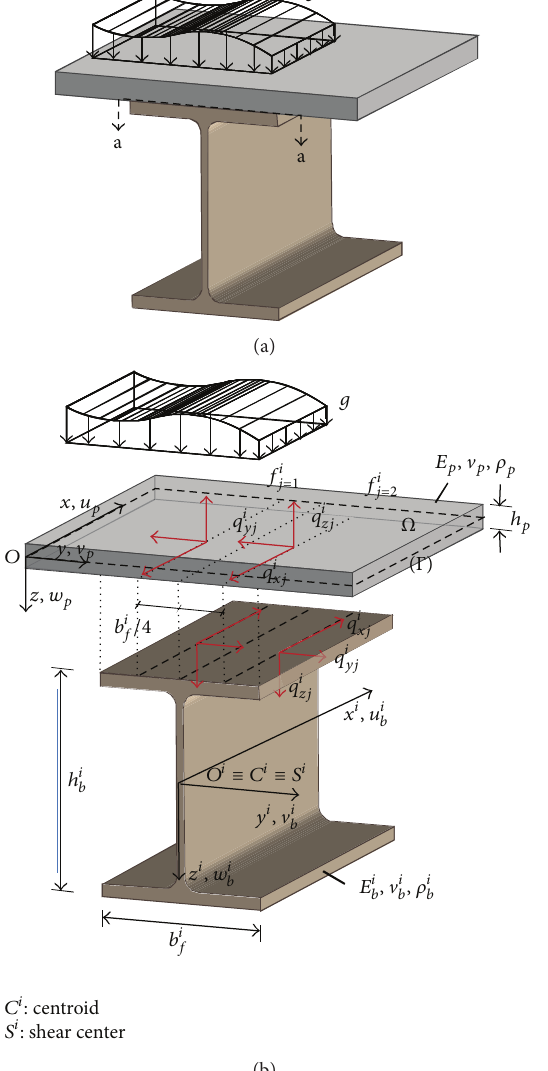
Figure 2: Thin elastic plate stiffened by beams (a) and isolation of the beams from the plate (b).